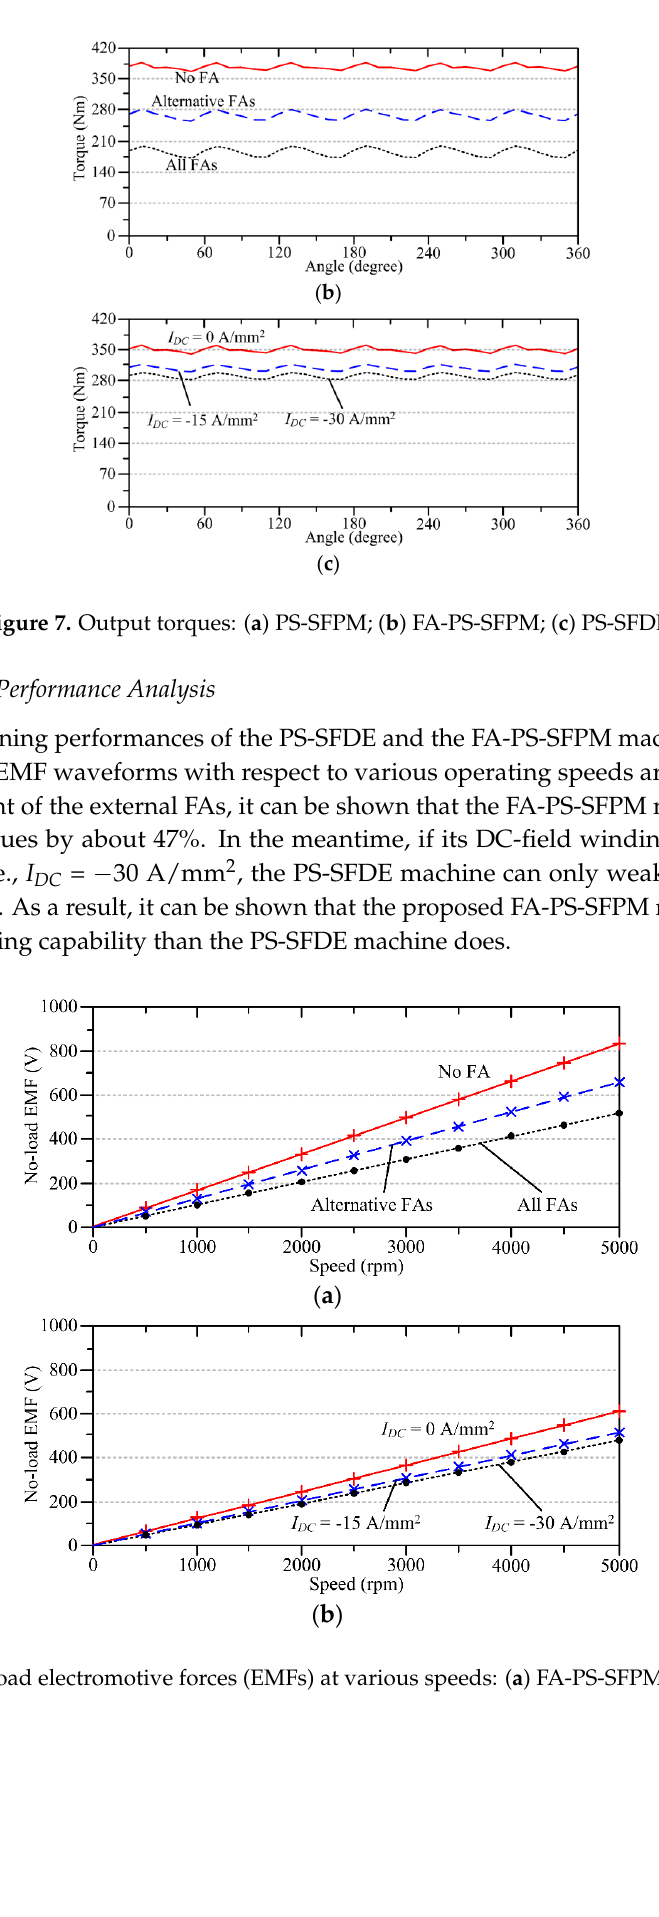
Figure 8. No-load electromotive forces (EMFs) at various speeds: ( a ) FA-PS-SFPM; ( b ) PS-SFDE.